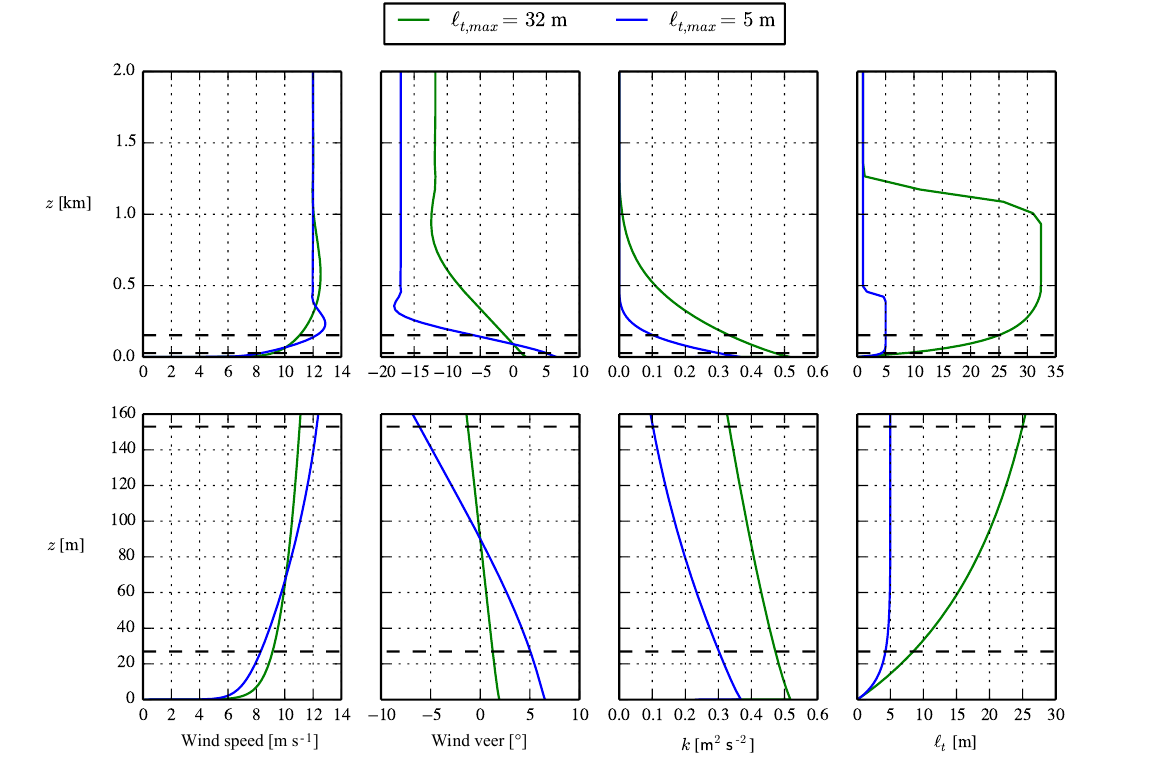
Figure 1. Rotated inlet profiles calculated by the precursor. Bottom plots are a zoomed view of the top plots. Rotor area is shown as black dashed